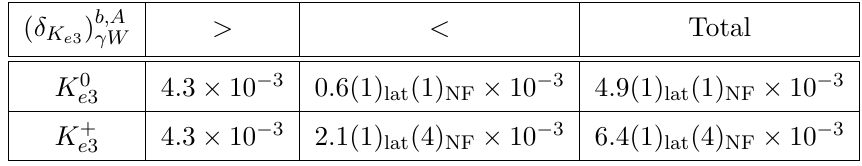
Table 3 . Contribution from δM b,A